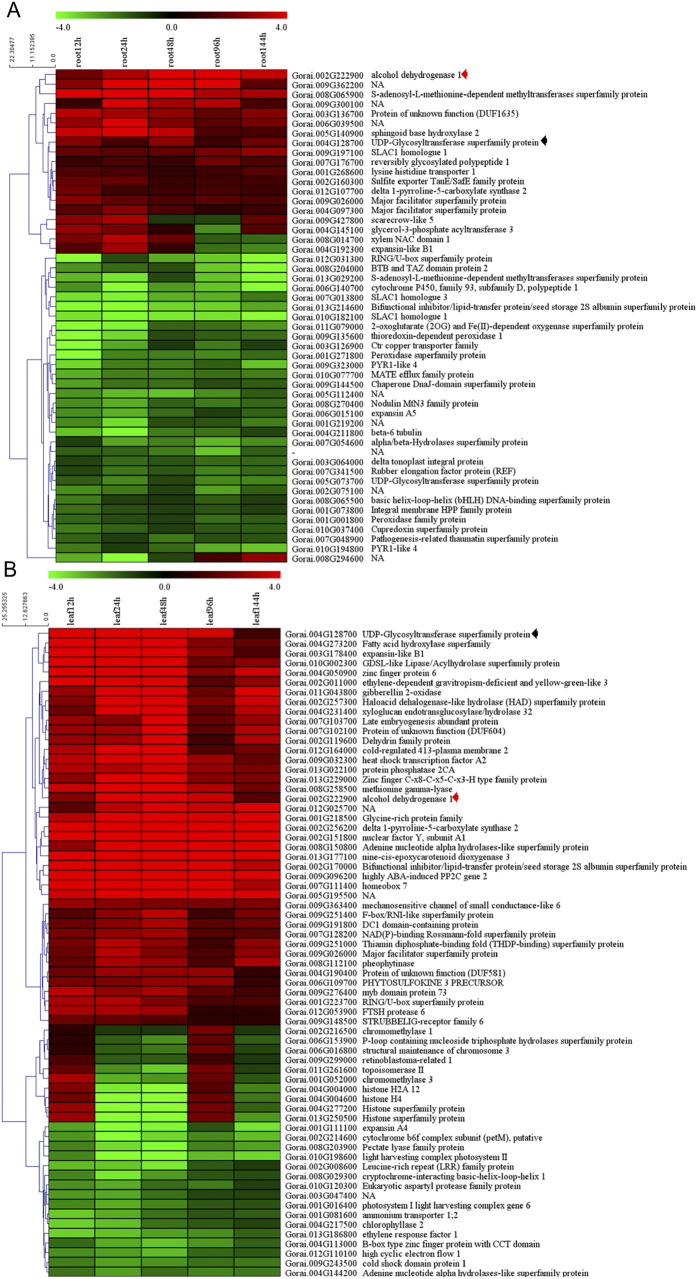
Heat map of DEGs at five time points in roots and leaves.(A) Heat map depicting log2
(fold change) of common differentially expressed genes in roots; (B) Heat map depicting log2
(fold change) of common differentially expressed genes in leaves. Red and green colors indicate up- and down- regulated transcripts, respectively, from both control and salt treated tissues. False Discovery Rate (FDR) ≤ 0.001 and the maximum value of |log2 (ratio of stress/control)| ≥ 1 was used as the cut-off to evaluate significant differences in expression). Red arrow: Alcohol dehydrogenase (ADH) in roots and leaves, respectively; Black arrow: UDP-Glycosyltransferase in roots and leaves, respectively.